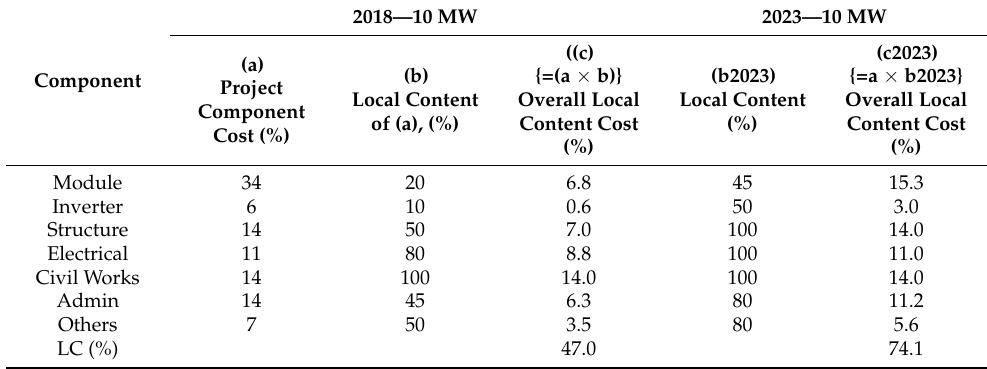
Table 1. Local Content (LC) estimate of a 10 MW (2018 and 2023 predicted) [23].